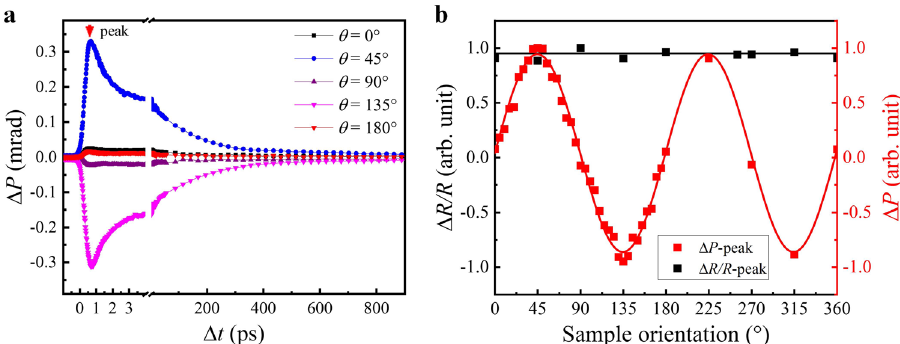
Fig. 2 Sample-orientation dependence of the transient MO Voigt signals. a Time evolution of Δ P for different θ . b The peak amplitude of Δ P and Δ R/R as a function of θ